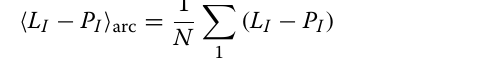
pose similar delay to the signals propagating to the two stations. That is, if a particular GNSS satellite is visible to two different GNSS stations present at a certain base- 1 line at the same UT, their average STEC, calculated using � L I − P I � arc = (5) N overlapping STEC arcs, considered as same. In this way, uncalibrated STEC data for which the receiver DCB is unknown can be calibrated using the calibrated STEC data from the other baseline GNSS station and the dif- ference of their STEC can be used to calculate DCB for uncalibrated station. STEC arc here is referred to the STEC data calculated using continuous observation between a GNSS station and a GNSS satellite. The term baseline is understood here as the straight-line distance between the two participating stations, that is, the uncali- brated GNSS station for which DCB is being calculated and the calibrated GNSS station from which the data is taken for the DCB calculation process. For the calibrated GNSS station, the STEC data is code-to-phase leveled as indicated in (6). The station from which the calibrated STEC is obtained will be referred to as ‘Ref’. Figure 1 (top panel) shows two arcs overlapping in time observed by two different GNSS stations MAL2 and MBAR. Station MAL2, used here as Ref, is calibrated for satellite and receiver biases available from IONEX files and leveled through carrier-to-code leveling process using (3), (4) and (6). Station MBAR is only corrected for the satellite biases available from the same source of IONEX data. Since the arc observed by station MAL2 is longer in time than the arc observed by station MBAR, we have only considered the length of the arcs from the two stations which are overlapping in time as shown in Fig. 1 (middle panel). These two arcs overlapping in time will be referred to as ‘overlapping arcs’. The bias between the two overlapping arcs is then calculated by taking the mean of the difference of the two overlapping arcs. This will be referred to as ‘arc bias’ and calculated as shown below: arc bias = L I ,arc,uncalib − (cid:31) L I ,arc,uncalib − ˜ L I ,arc (cid:30)